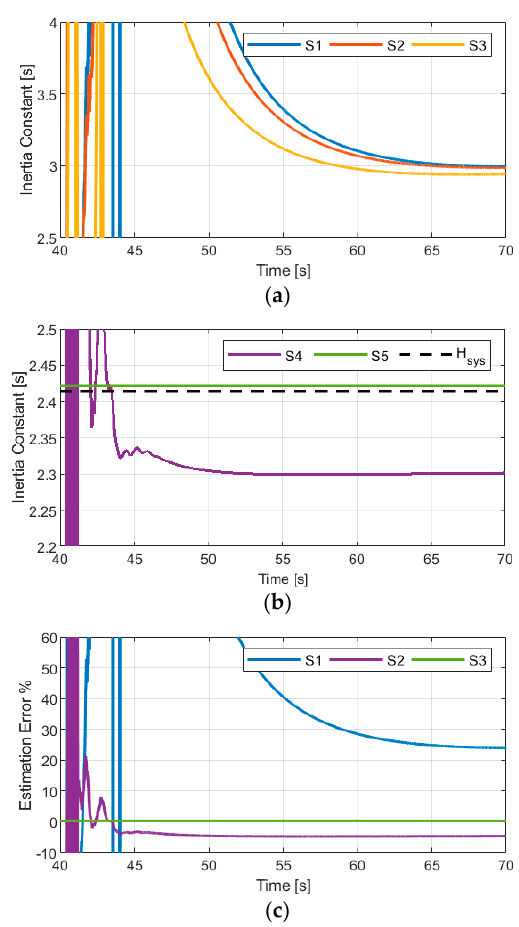
Figure 5. Comparison of the inertia estimation performance of systems with mixed generation: ( a ) the estimated total inertia constant in scenarios S1, S2 and S3; ( b ) the estimated total inertia constant in scenarios S4 and S5; ( c ) the relative estimation error of the total inertia constant in systems with mixed generation.